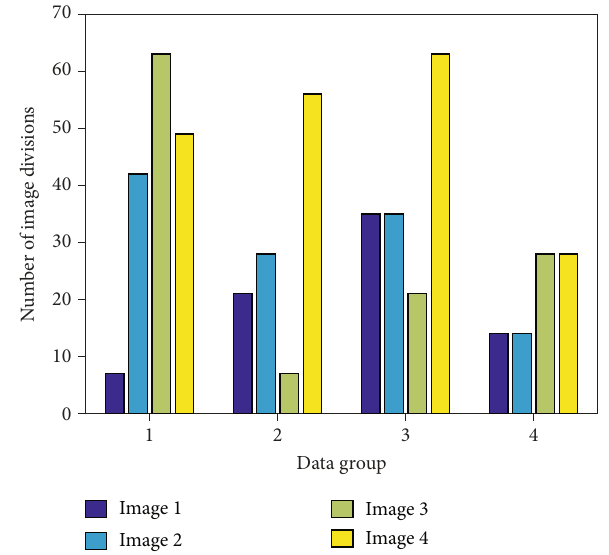
Figure 7: The histogram distribution of the number of divisions in the highlight area of di ff erent images.